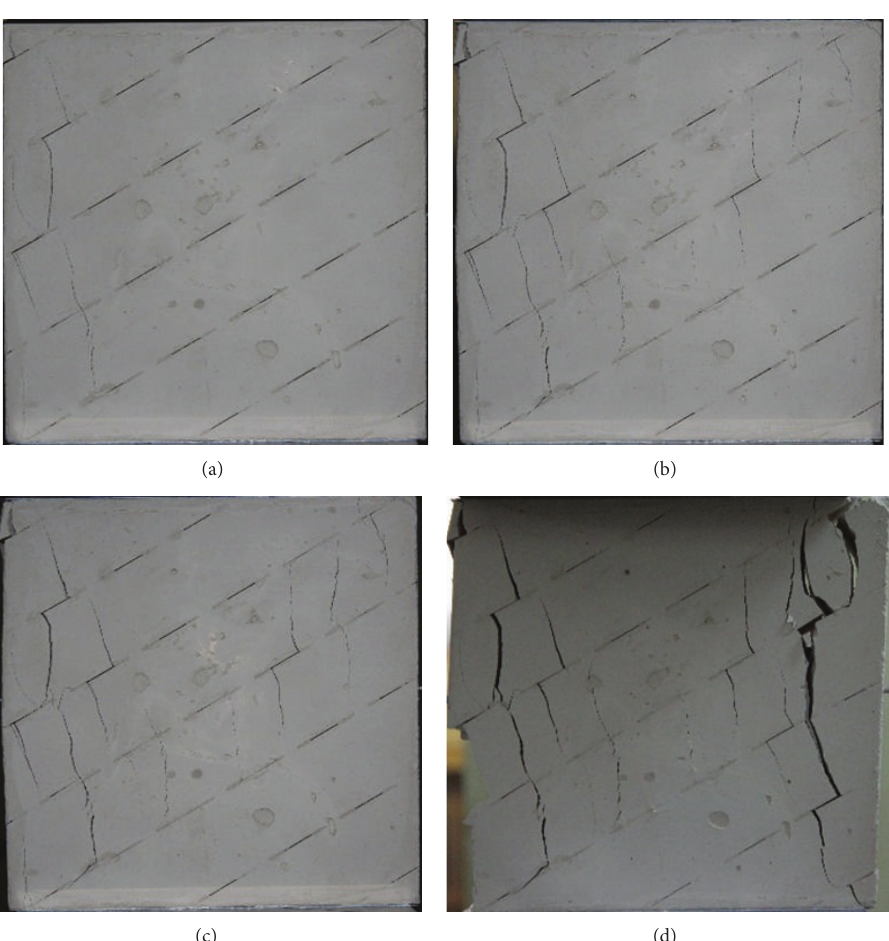
Figure 5: Cracks growth and failure mode of specimen